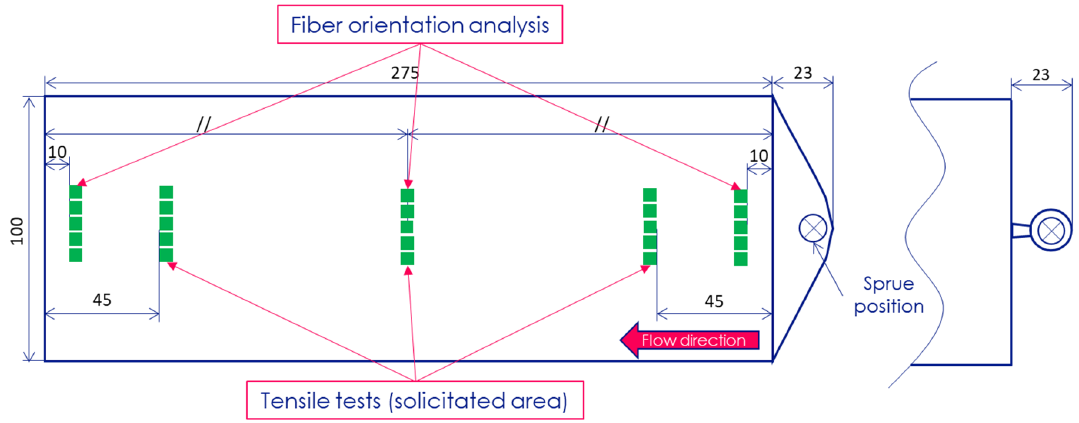
Figure 2. Positions and injection configurations of the part samples used in the study: (Left) fan gate, (right) tab gate.